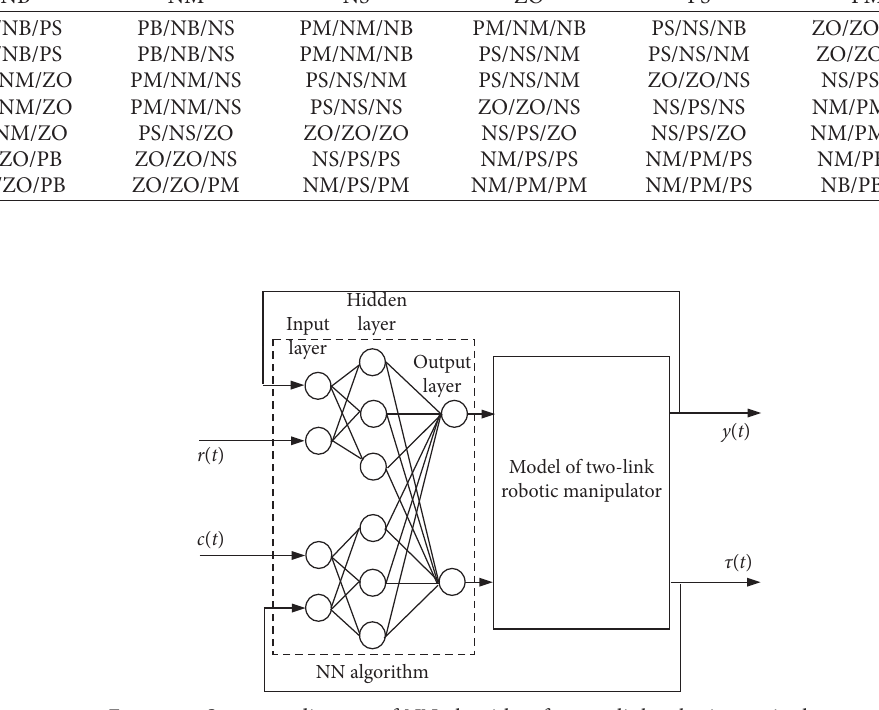
Figure 5: Structure diagram of NN algorithm for two-link robotic manipulator.